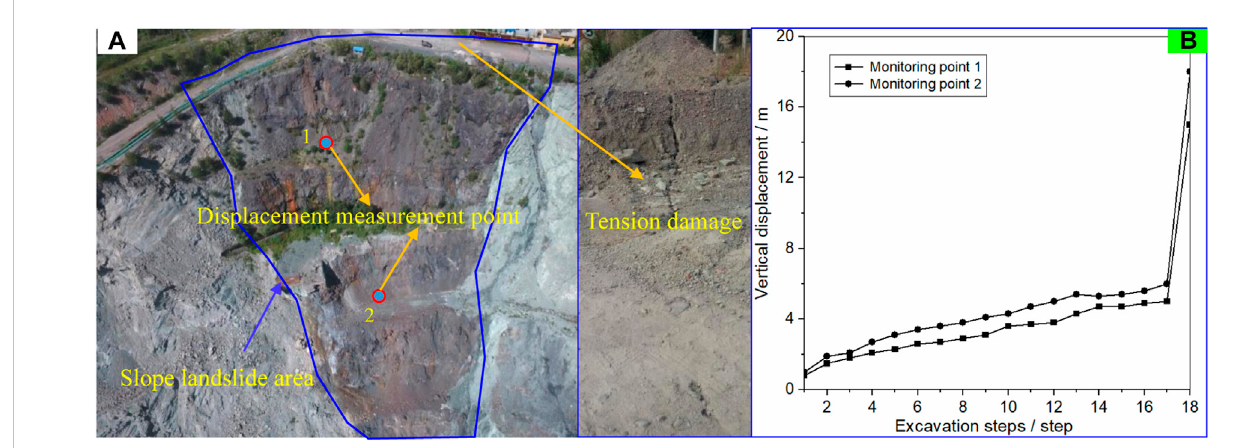
FIGURE 13 (A) Layout of the on-site measuring points and (B) displacement monitoring